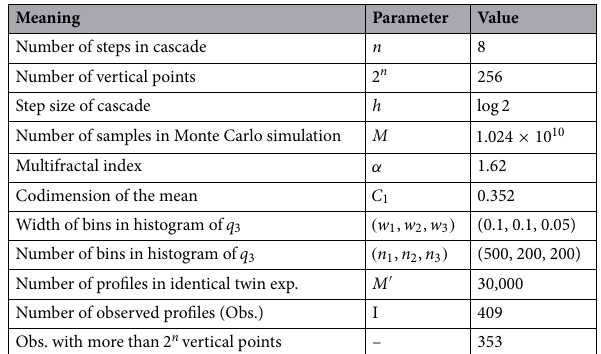
Table 2. Constants and parameters for the estimation study.